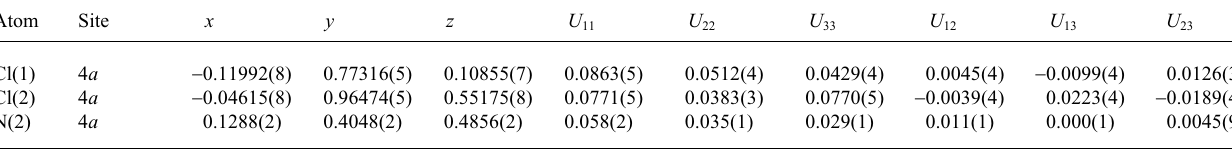
Table 3. Atomic coordinates and displacement parameters (in Å 2